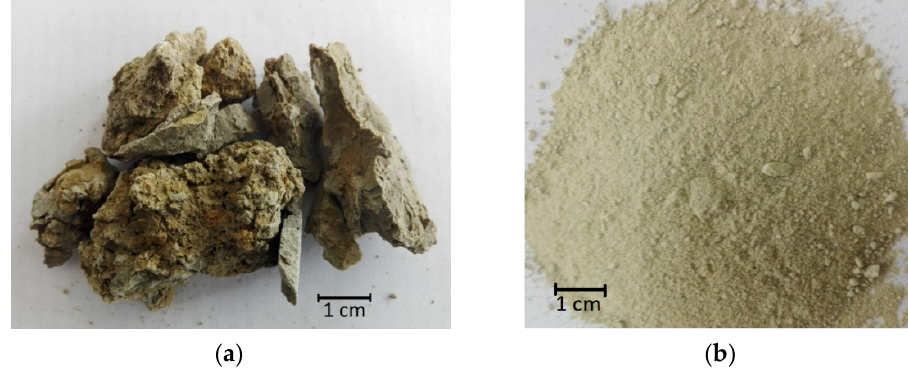
Figure 1. ( a ) Raw and ( b ) comminuted Pliocene